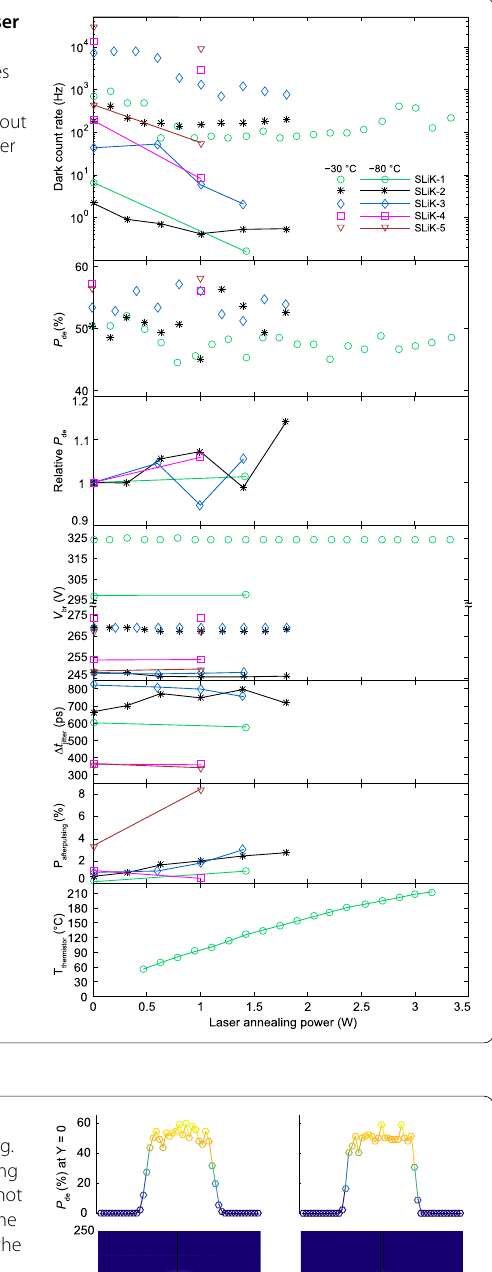
Figure 6 Detection efficiency scan of SLiK-1. (a) Prior to annealing, and (b) after 3.3 W annealing. The spatial profile is essentially unchanged, proving that focused high-power laser illumination does not degrade photosensitivity in the active region of the APD for the power range we tested. The plots at the top are the cross sections at Y =